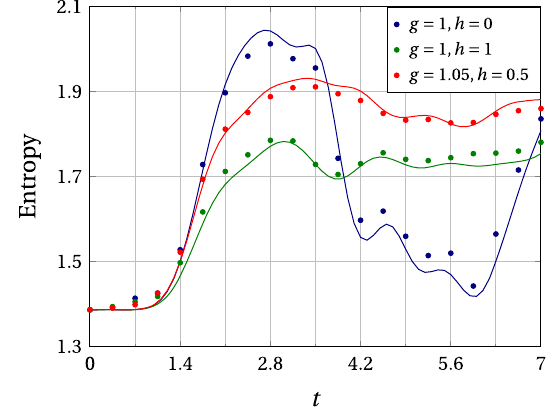
2 Þ A after a quench. A quench